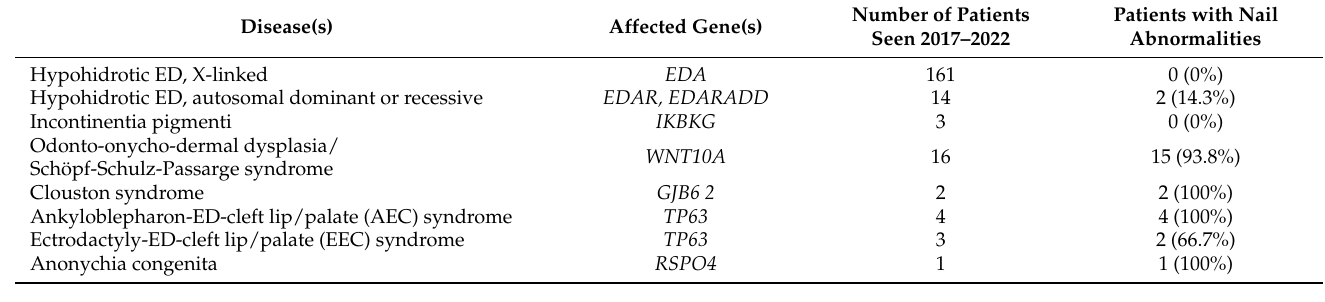
Table 1. Proportion of nail abnormalities among children with clinically suspected ED seen at the CEDER in the last five years.